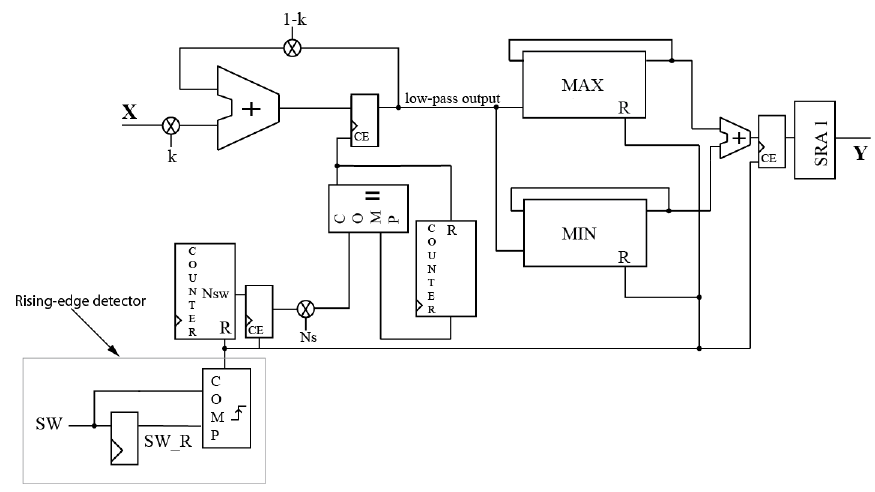
Figure 6. Digital schematic of the Hybrid filter.